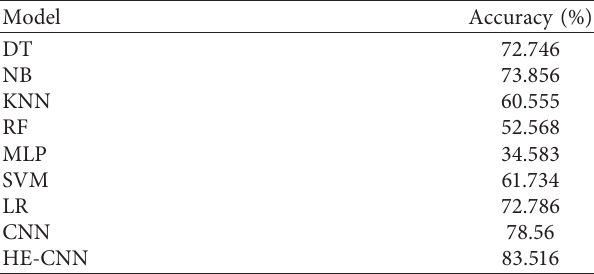
Figure 6: Preference distribution in the 2010s. Table 5: Classification performance of different models on our HE dataset.